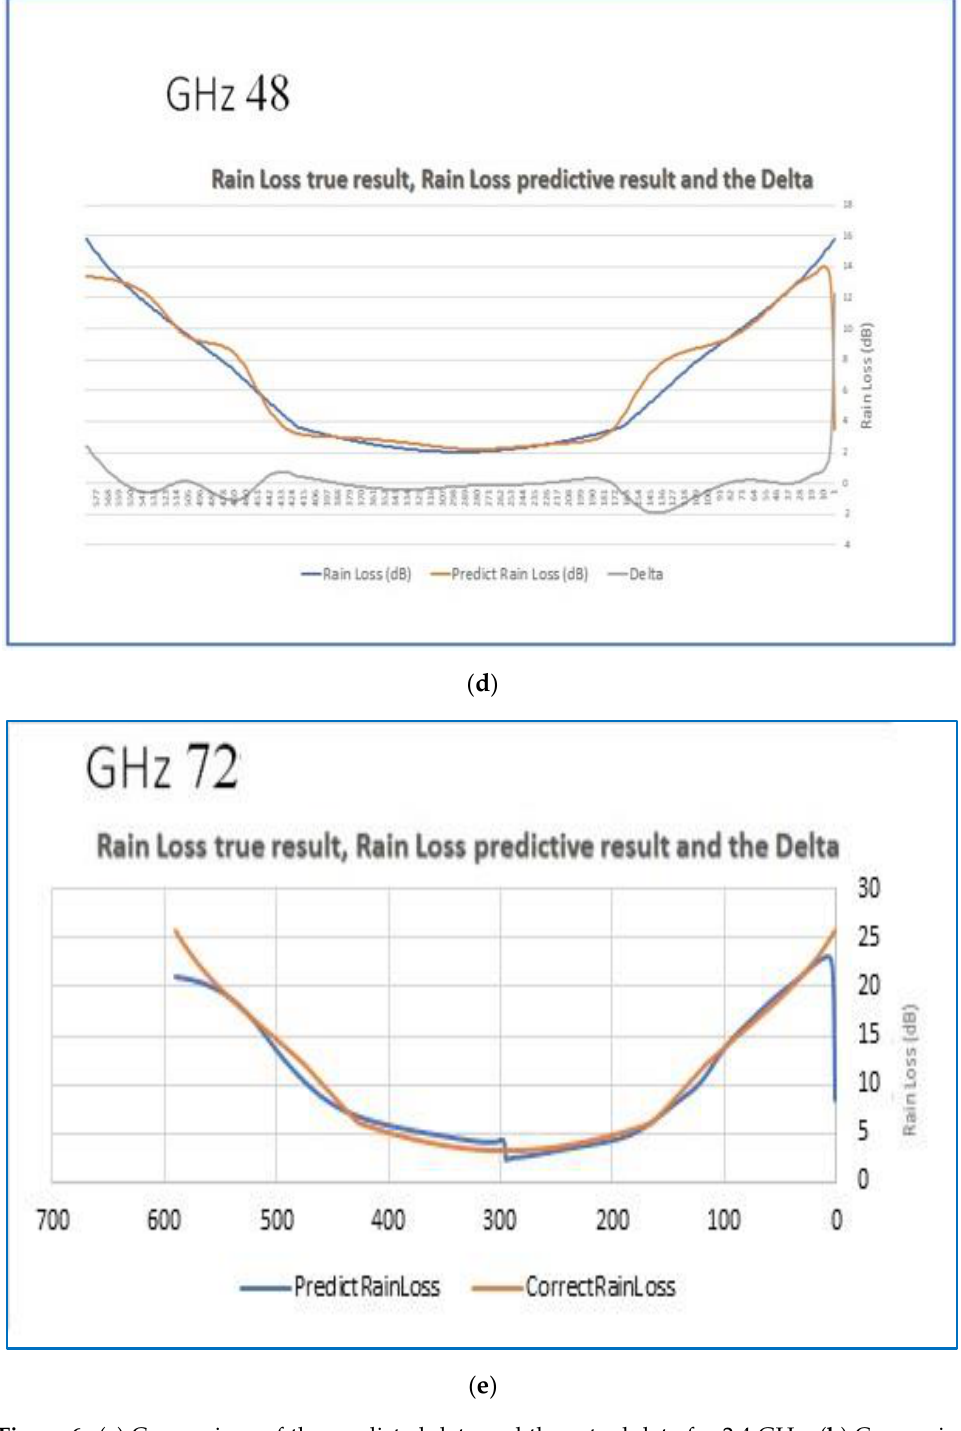
Figure 6. ( a ) Comparison of the predicted data and the actual data for 2.4 GHz; ( b ) Comparison of the predicted data and the actual data for 10 GHz; ( c ) Comparison of the predicted data and the actual data for 23 GHz; ( d ) Comparison of the predicted data and the actual data for 48 GHz; ( e ) Comparison of the predicted data and the actual data for 72 GHz. Reprinted with permission from ref. [1]. Copyright 2021 IEEE.